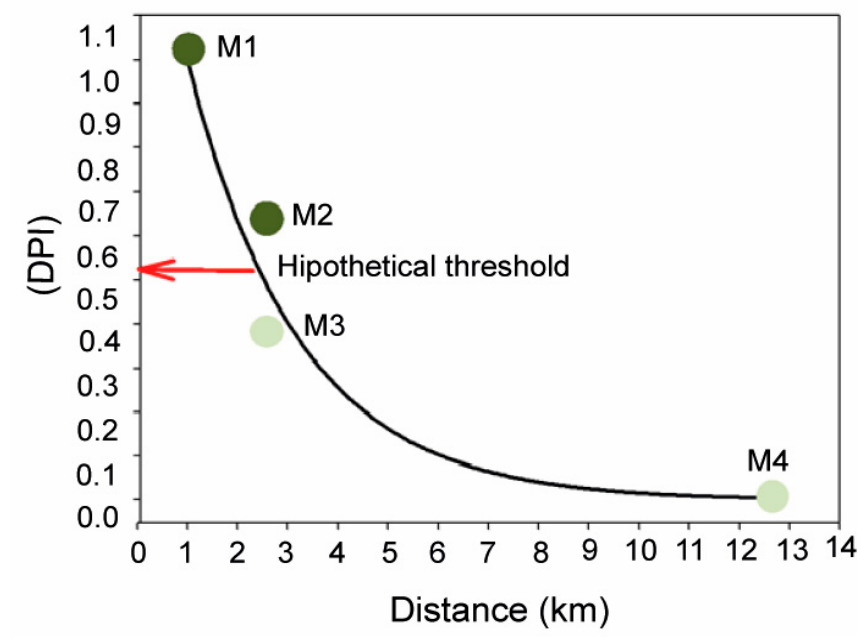
Figure 7. Relationship between the degree of pressure influence (DPI, score of PCA axis I) and the distance from each studied site (M1–M4) to the nearest anthropogenic nutrient source. The solid line corresponds to the theoretical exponential decay model fitted to the data to illustrate the inverse relationship between the two variables. As it is suggested in the text, the sudden shift from a healthy meadow state (i.e., with the integrity of the meadow structure intact; light green circles) to a degraded state (i.e., with an altered meadow structure; dark green circles) could be explained by the existence of a hypothetical threshold (red arrow) as a result of a non-lineal relationship between seagrass status and the pressure intensity.